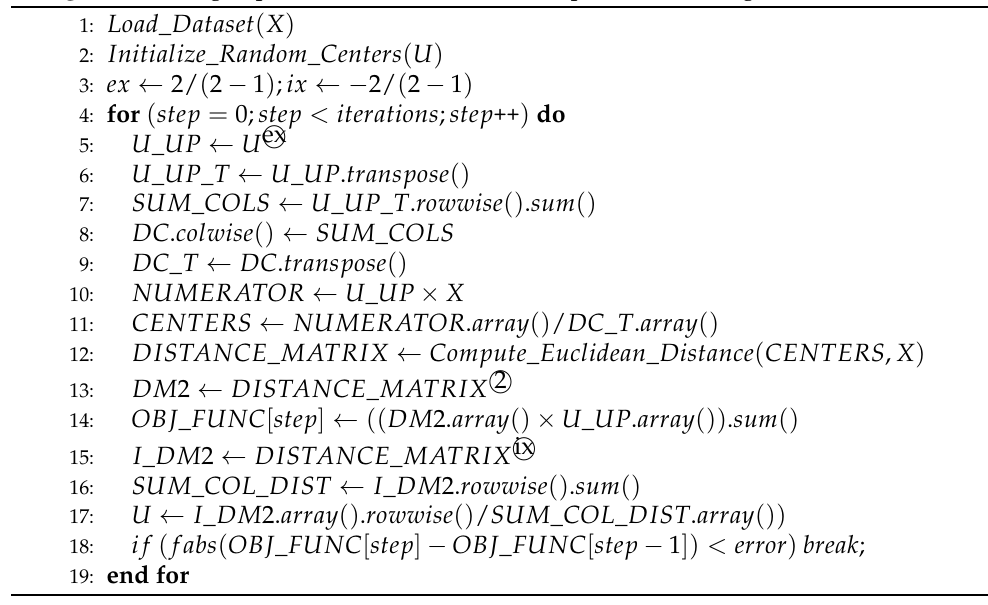
Algorithm 6: Eigen pseudocode for the main loop of the FCM algorithm.